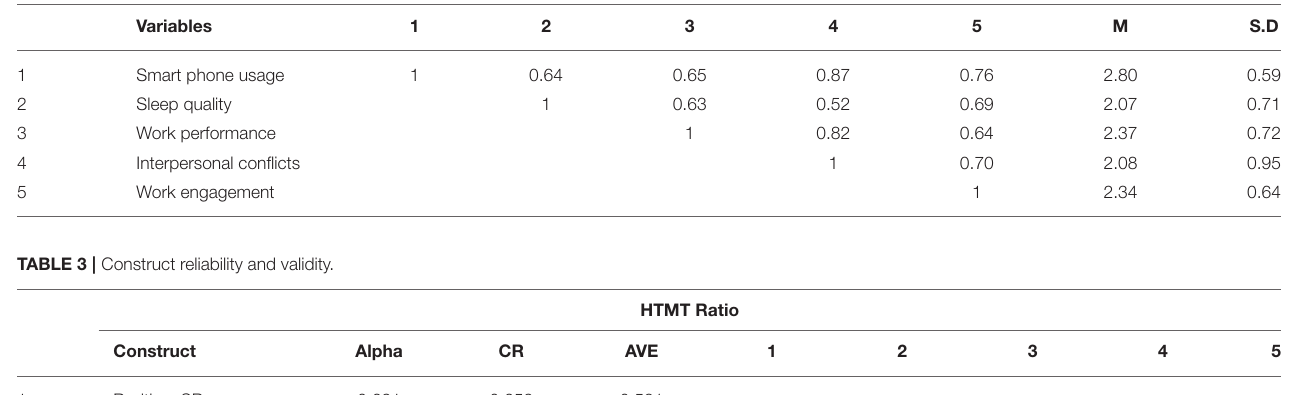
TABLE 2 | Pearson correlation, mean, standard deviation.